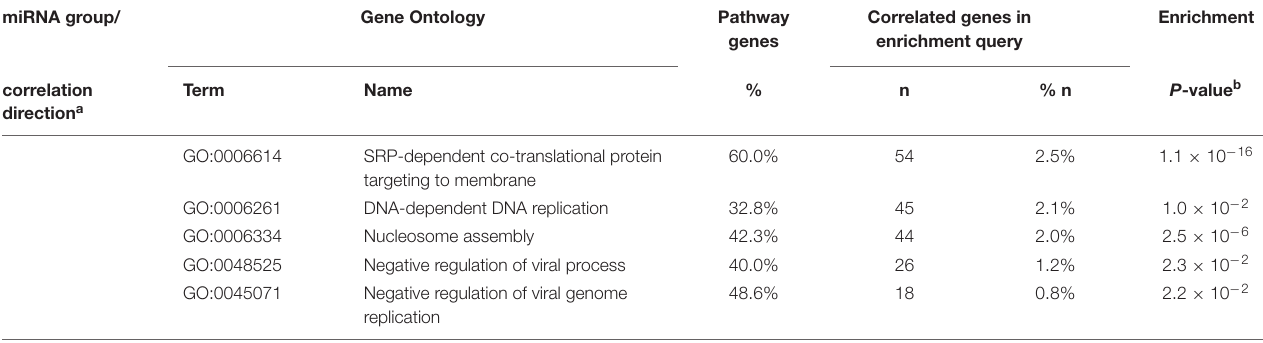
Frontiers in Cell and Developmental Biology |